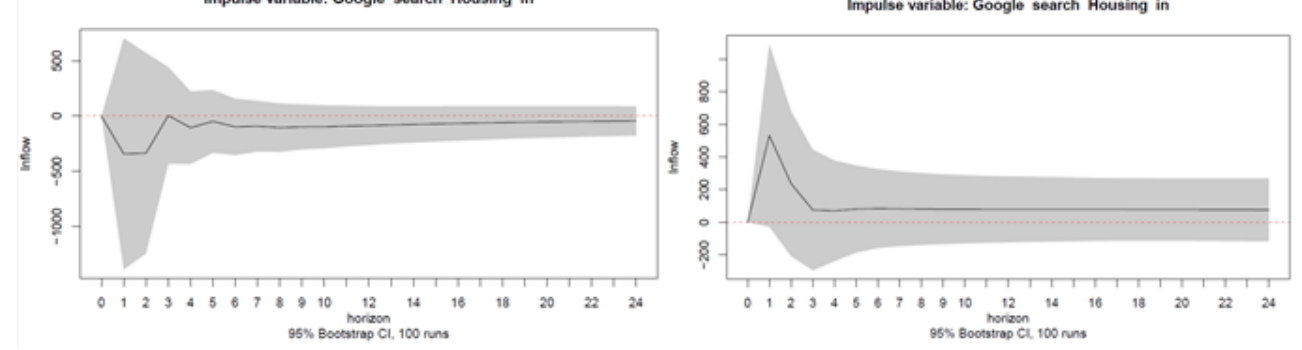
Figure A7. Orthogonal impulse responses from a shock in Google online searches on migration inflow in Moscow ( left column ) and Saint Petersburg ( right column ) using a TVVAR (1) model. The values reported are the means of the time-varying IRF over each period.